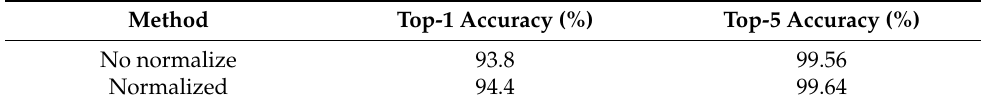
Table 4. Action recognition accuracies by baseline, tested on CSL-500